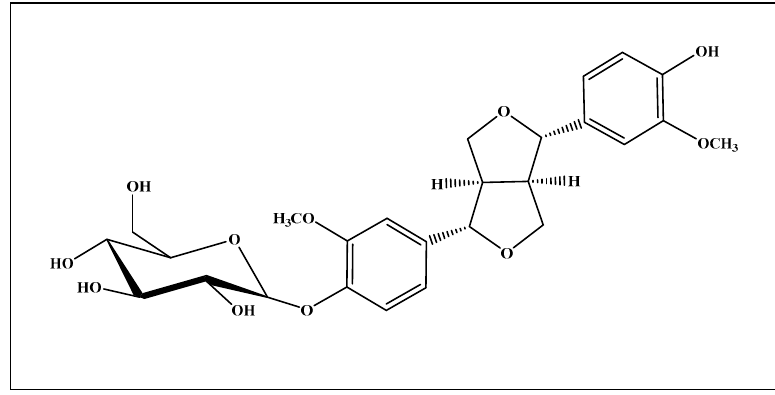
Figure 1. Pinoresinol-4- O - β - D -glucopyranoside (PGu) structure.